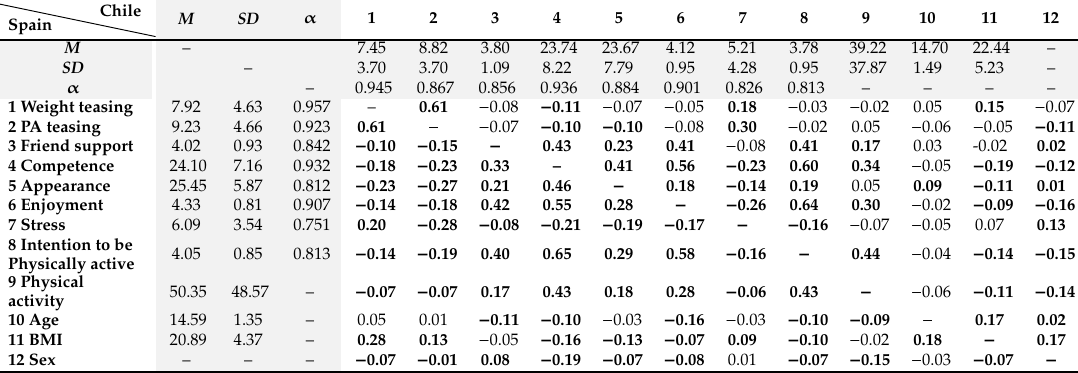
Note. Significant correlations appear in bold